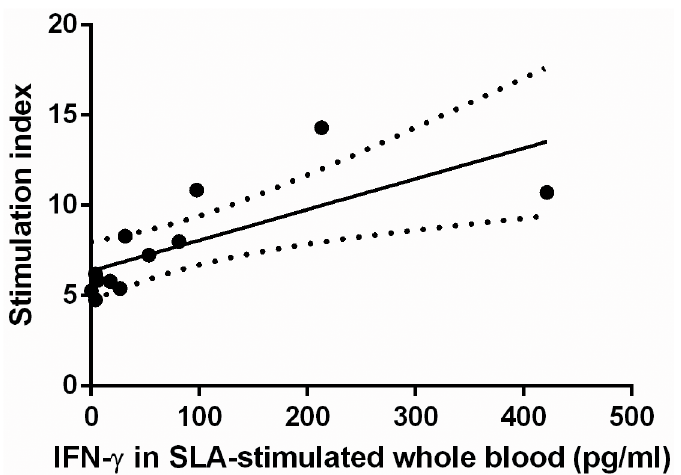
Fig 6. Linear regression of stimulation index and IFN- γ in plasma from SLA-stimulated whole blood plasma from NVL lp+ subjects. A significant correlation was detected between these variables (r = 0.881, P =